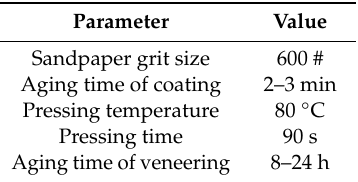
Table 1. Parameters in the process of